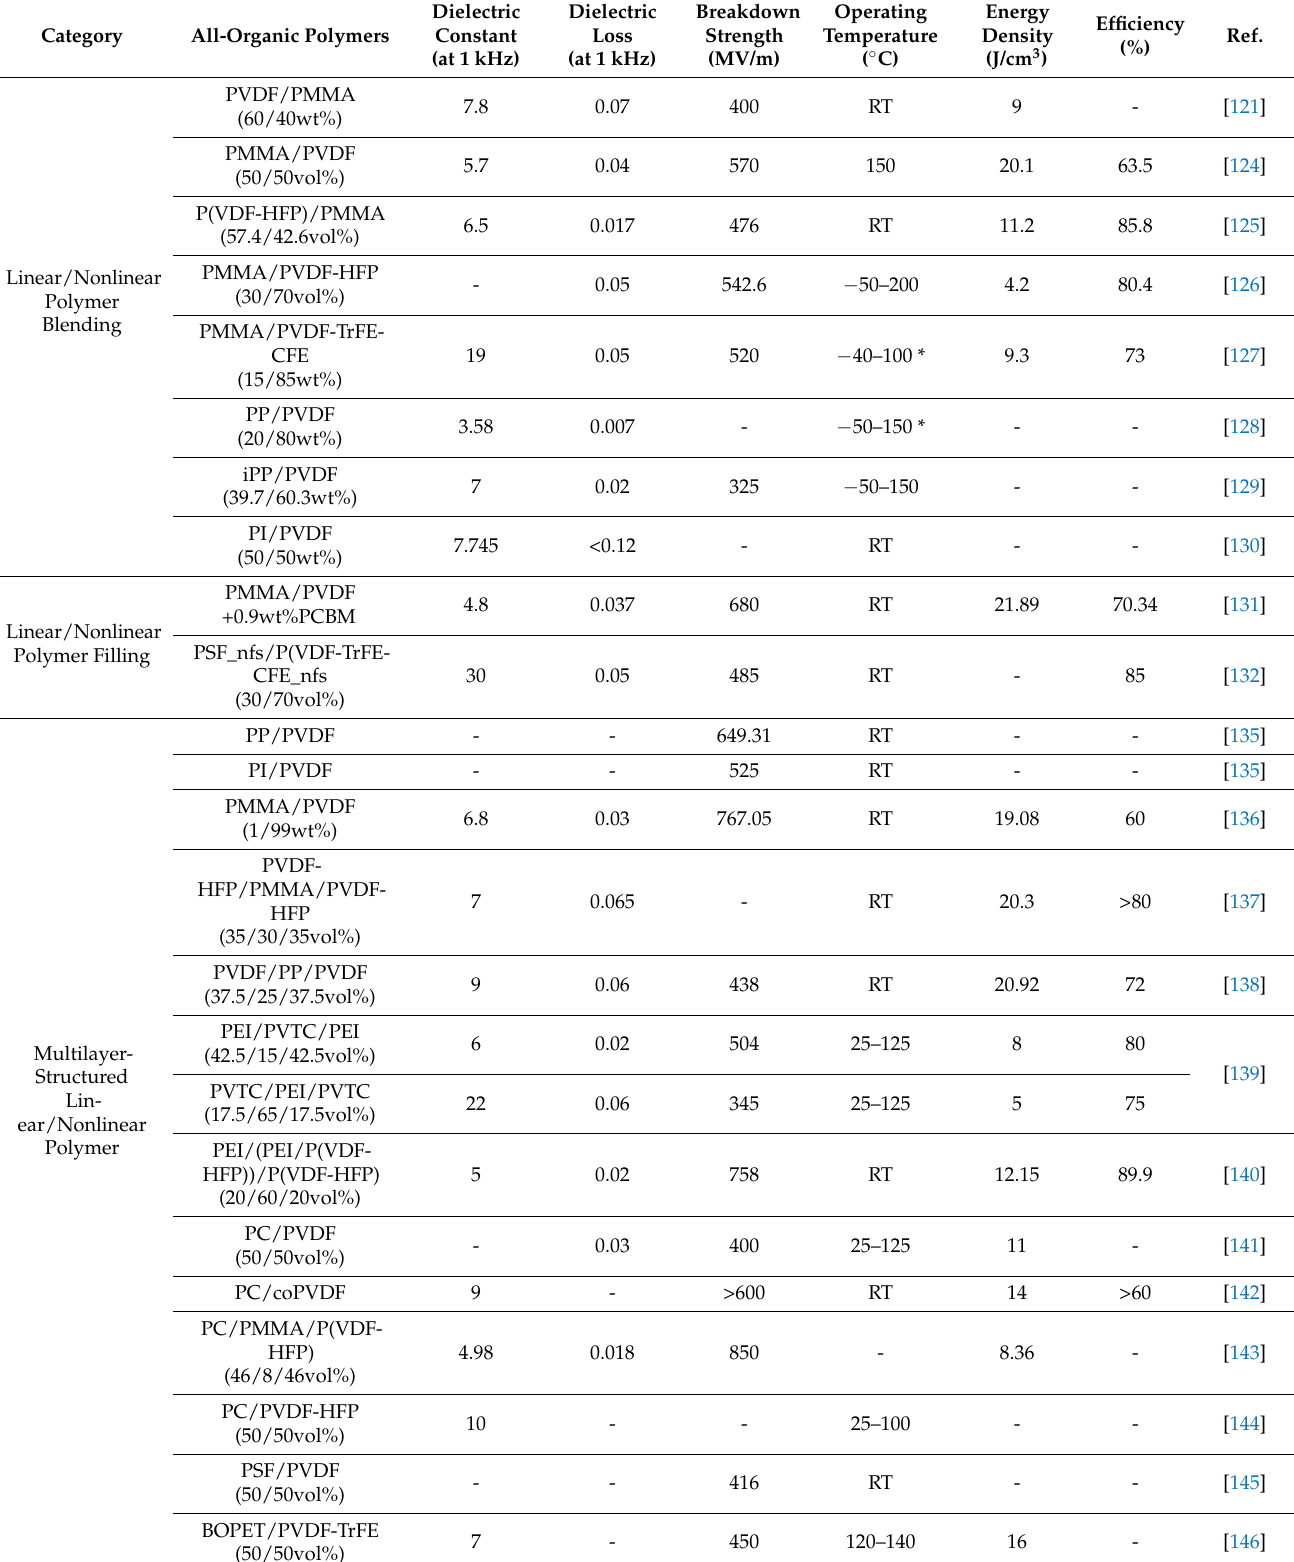
Table 5. Dielectric and Energy Storage Properties of Linear/Nonlinear Polymer